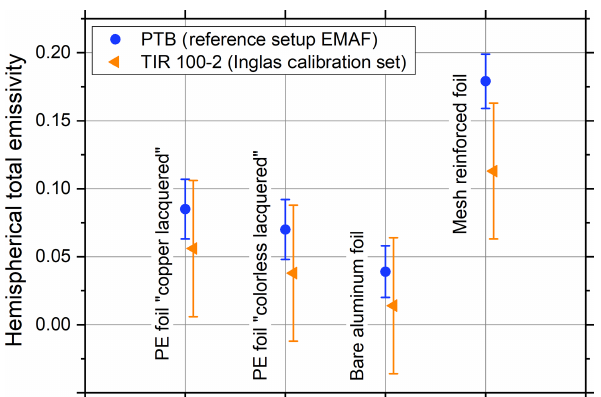
Figure 12. Hemispherical total emissivities of selected foils mea- sured by the EMAF at PTB and by the TIR 100-2 according to EN